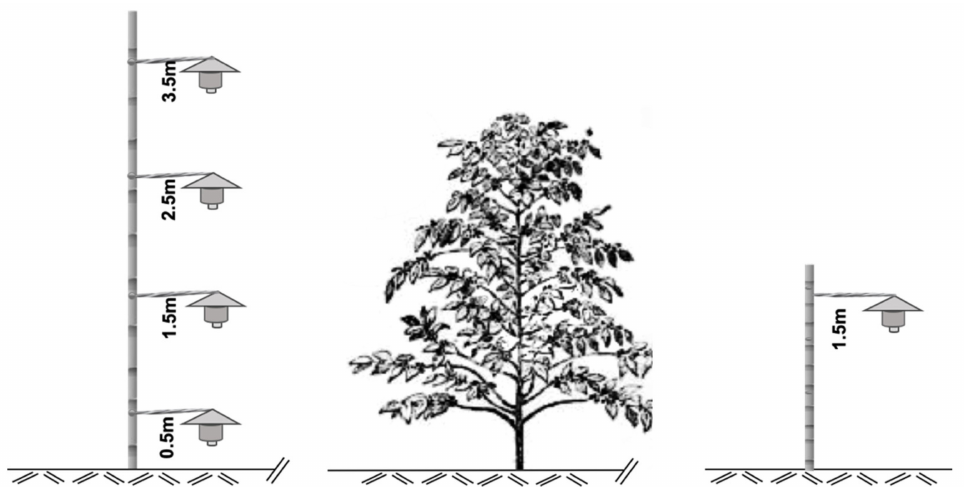
Figure 1. Representative illustration of column traps (CT). Each CT comprised of four traps placed at 0.5 m, 1.5 m, 2.5 m, and 3.5 m above ground and a single trap (ST) at 1.5 m above ground. The field experiments were conducted in Adjuntas, Puerto